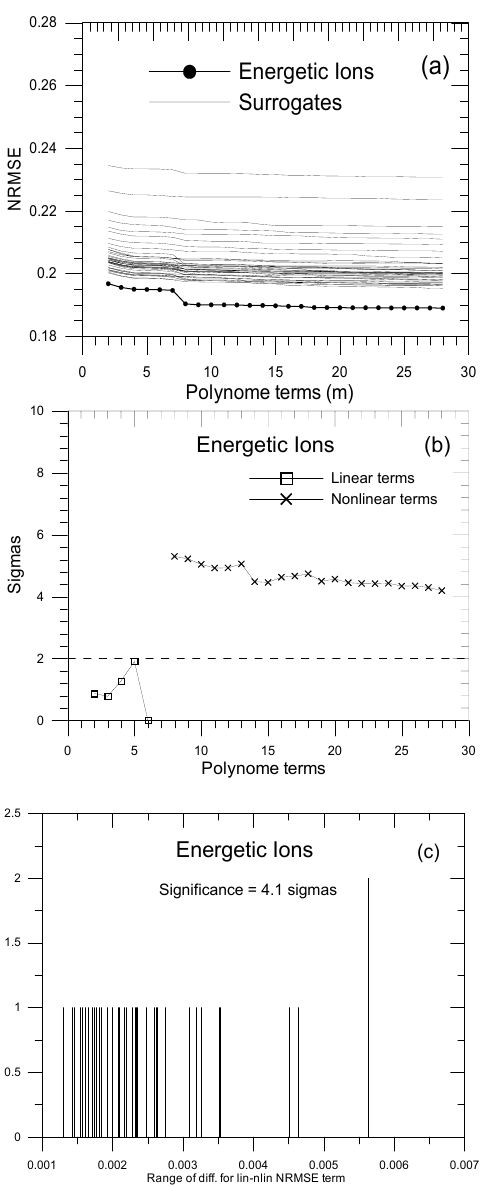
Fig. 9. (a) Normal root mean squares error (NRMSE) estimated by Figure 9 using a polynomial fitting for the energetic ions’ time series and its surrogate data, as a function of the polynomial terms, of the Voltera- Wiener model estimated for parameters m = 6 ,τ = 30 ,q = 2 and 5 steps ahead mappings. The first seven terms are linear and the next terms are nonlinear. (b) Significance of the reduction error statis- tic corresponding to the difference between the polynomial fitting of the first seven linear terms from the polynomial fitting contain- ing all the possible linear-nonlinear terms. (c) The discriminating statistic of the reduction error for the energetic ions (tall line) and the surrogate data (short line) corresponding to the difference be- tween the polynomial fitting of the first seven linear terms from the polynomial fitting containing all the linear-nonlinear